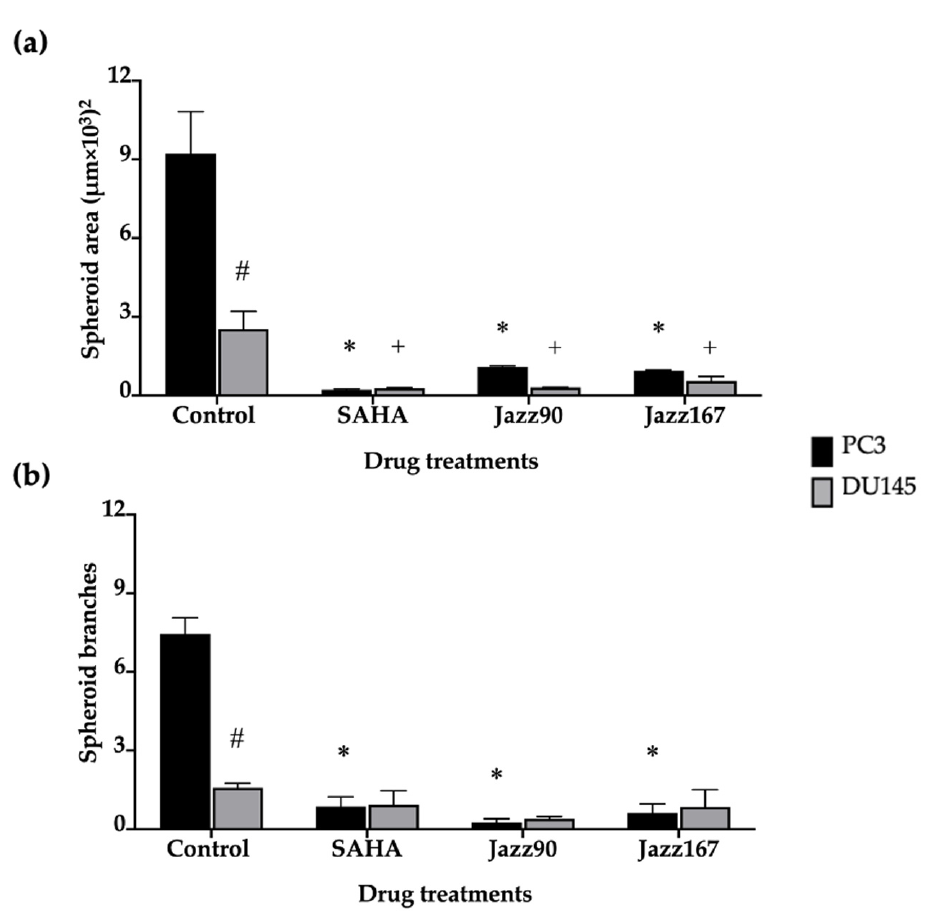
Figure 6. Effect of HDAC inhibitors on the area and branching of prostate cancer spheroids. ( a ) Spheroid areas and ( b ) branches of spheroids formed from PC3 and DU145 cells. Bars represent the mean ± S.E.M. from 3 independent experiments, each containing 100 spheroids. Data were analysed using a one-way ANOVA coupled with a Bonferroni’s post-hoc test. * significantly different compared to control in PC3 cells, #significant reduction in control spheroid areas between PC3 and DU145 cells, + significantly different compared to control in DU145 cells, p < 0.05.